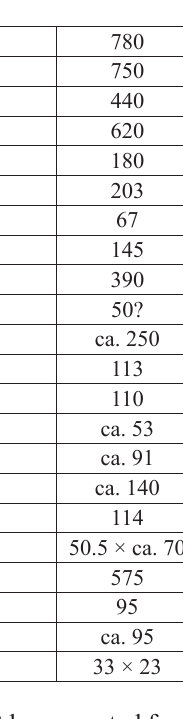
Table 1. Measurements (in mm) of skull FSC-Sk-250. Numbers of Guérin (1980) in